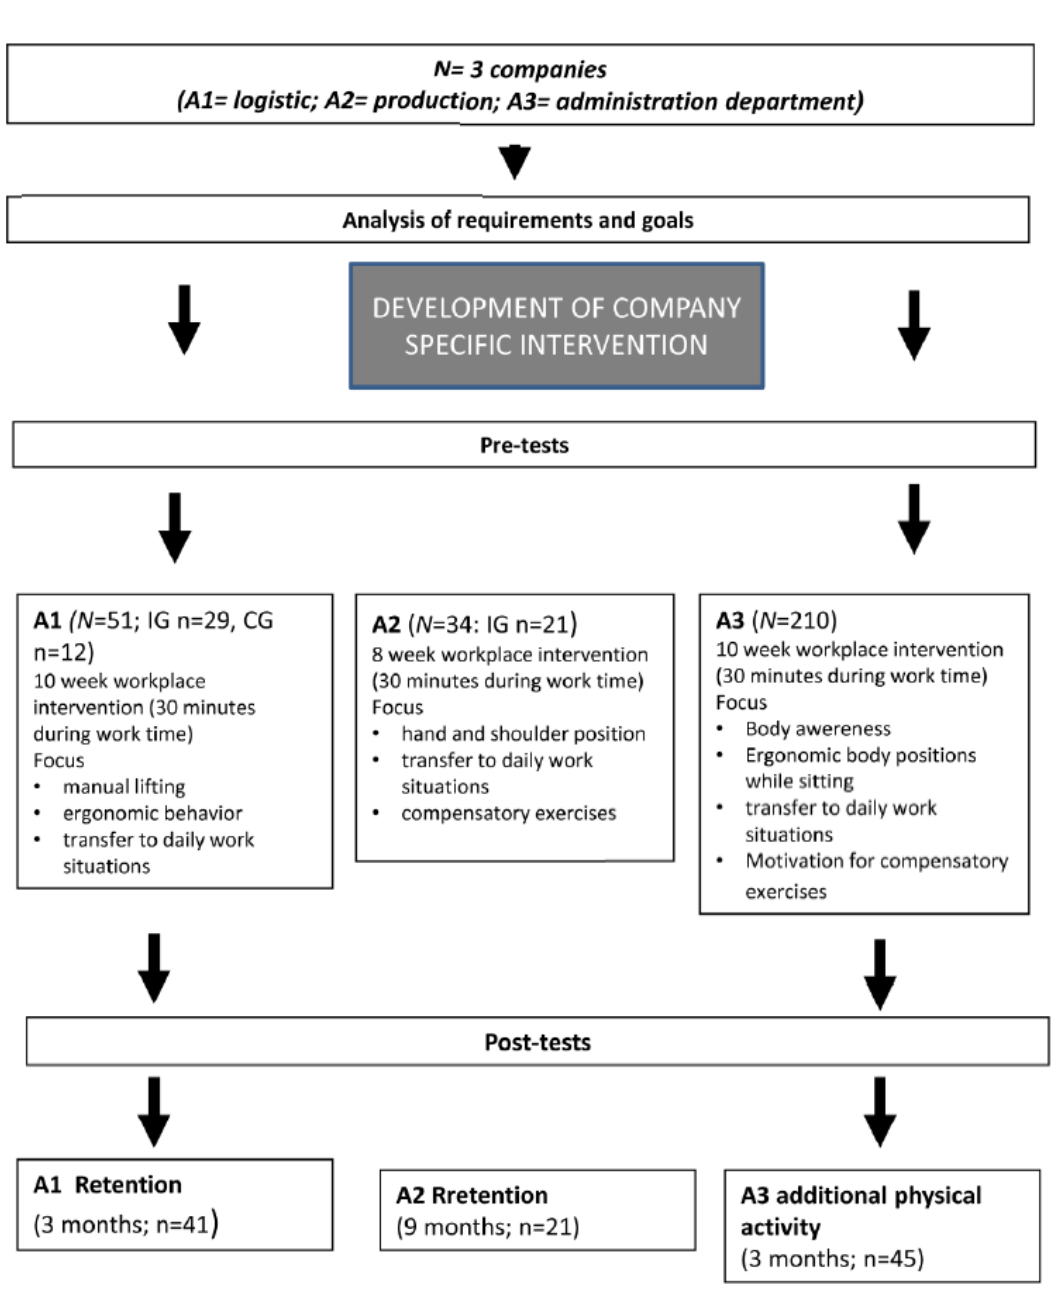
Figure 2. Workflow for all application fields.